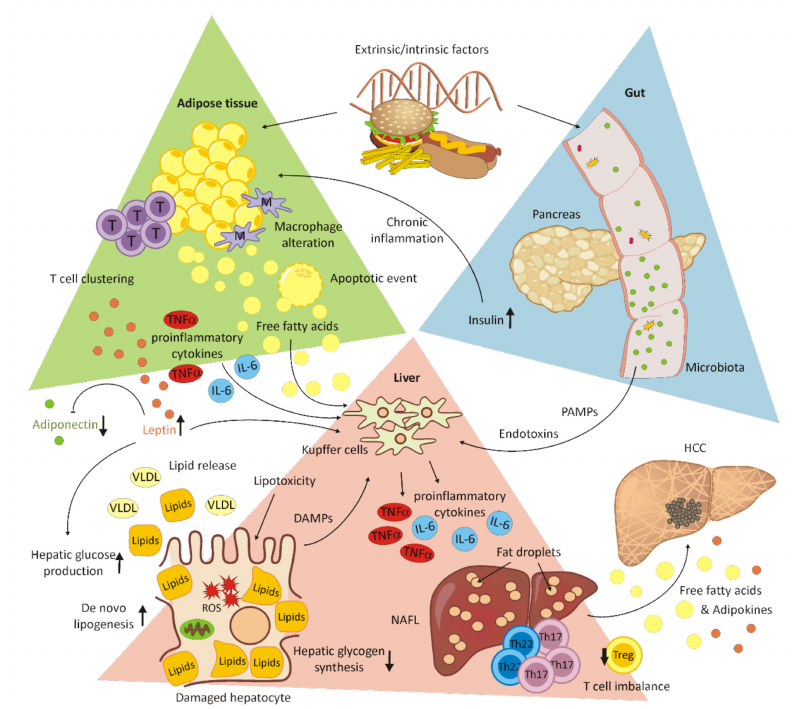
Figure 3. Chronic inflammation in adipose tissue and its effects on the liver. Adipose tissue. Chronic inflammation of the adipose tissue results in T cell clustering and ATM alteration results in charac- teristic apoptotic events in adipocytes and elevated levels of circulating free fatty acids, which can directly stimulate Kupffer cells. Leptin is involved in glucose homeostasis and immune response. High levels of leptin in obese individuals, together with low levels of adiponectin, contribute to disease progression to steatosis and fibrosis. Gut/Pamcreas. Hyperinsulinemia induces chronic inflammation in adipose tissue, while gut-derived endotoxins and PAMPs, together with DAMPs of dying hepatocytes, activate Kupffer cells in the liver, which secrete proinflammatory cytokines. Liver. Lipid overload in the liver triggers hepatocyte cell death, while DAMPs are released and inflate inflammatory processes in the liver. Kupffer cells and monocyte-derived macrophages (not shown) promote liver inflammation by the secretion of proinflammatory cytokines. The proinflammatory imbalance in favor of proinflammatory Th17/Th22 T cells versus Treg cells. Abbreviations (in